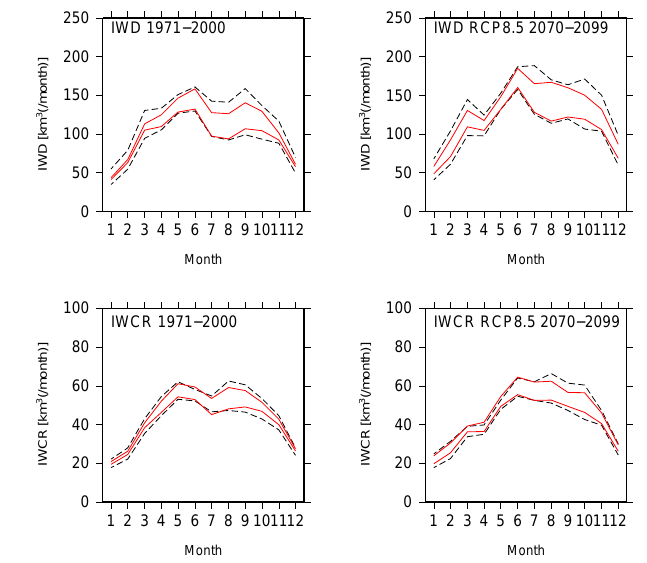
Figure 16. Changes in monthly ranges of irrigation water demand (IWD) and irrigation water consumption from rivers (IWCR) after correcting humidity bias. Broken black and solid red lines show the results with uncorrected and bias-corrected humidity data, respec- tively. Each pair of lines gives the maximum and minimum values for the five